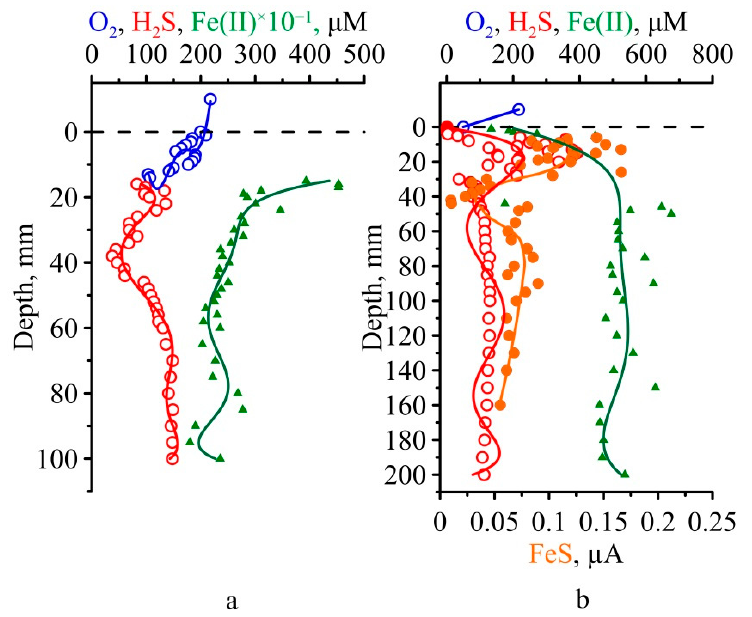
Figure 5. Vertical distribution of pore water components of bottom sediments in the SCC region: ( a ) St. 41; ( b ) St. 57.